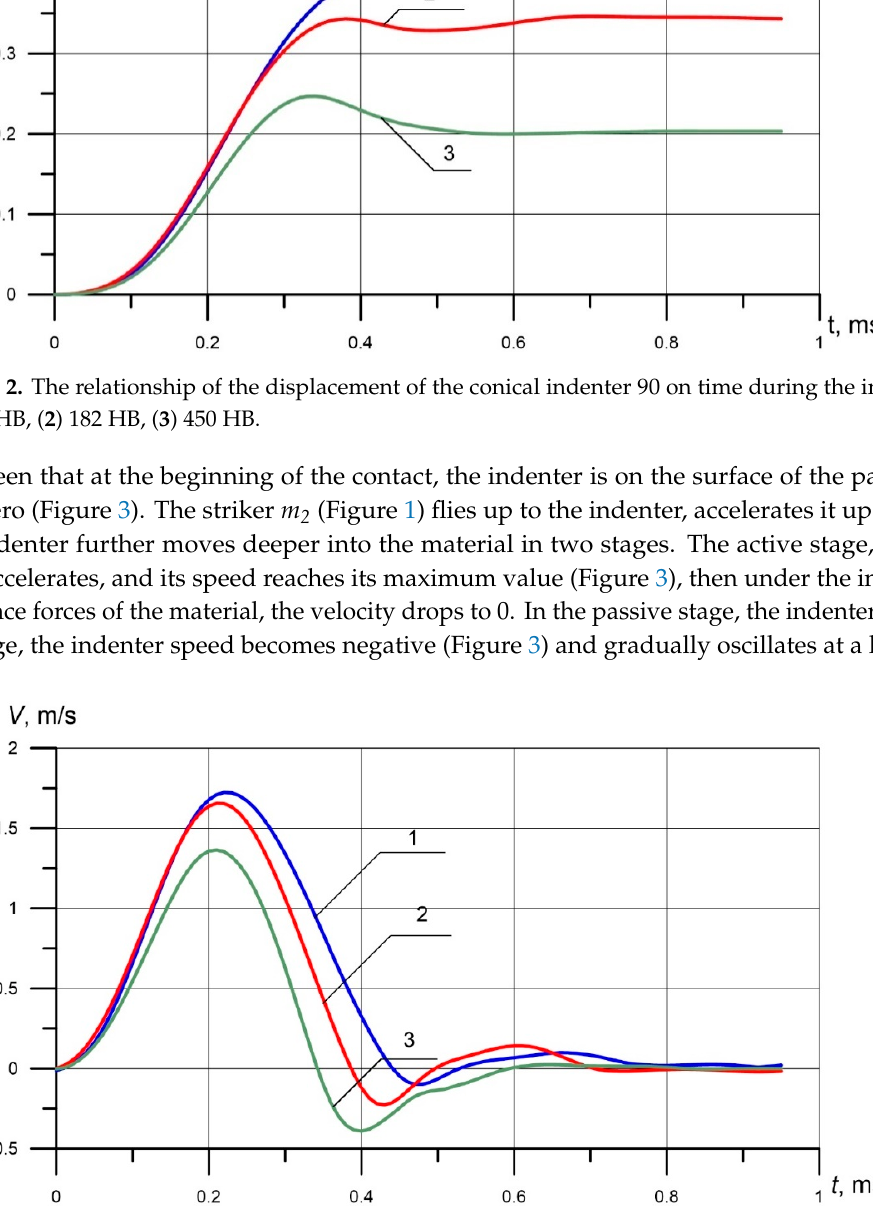
Figure 3. The relationship of the velocity of the conical indenter 90 on time during the impact: ( 1 ) 96 HB, ( 2 ) 182 HB, ( 3 ) 450 HB.